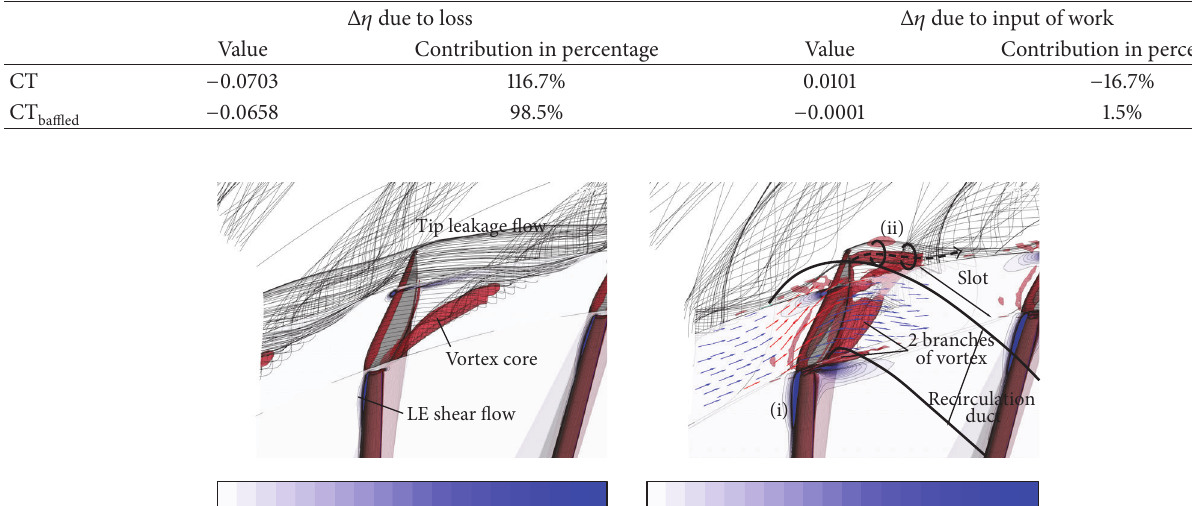
Table 3: The contribution of change of loss and work input to efficiency.